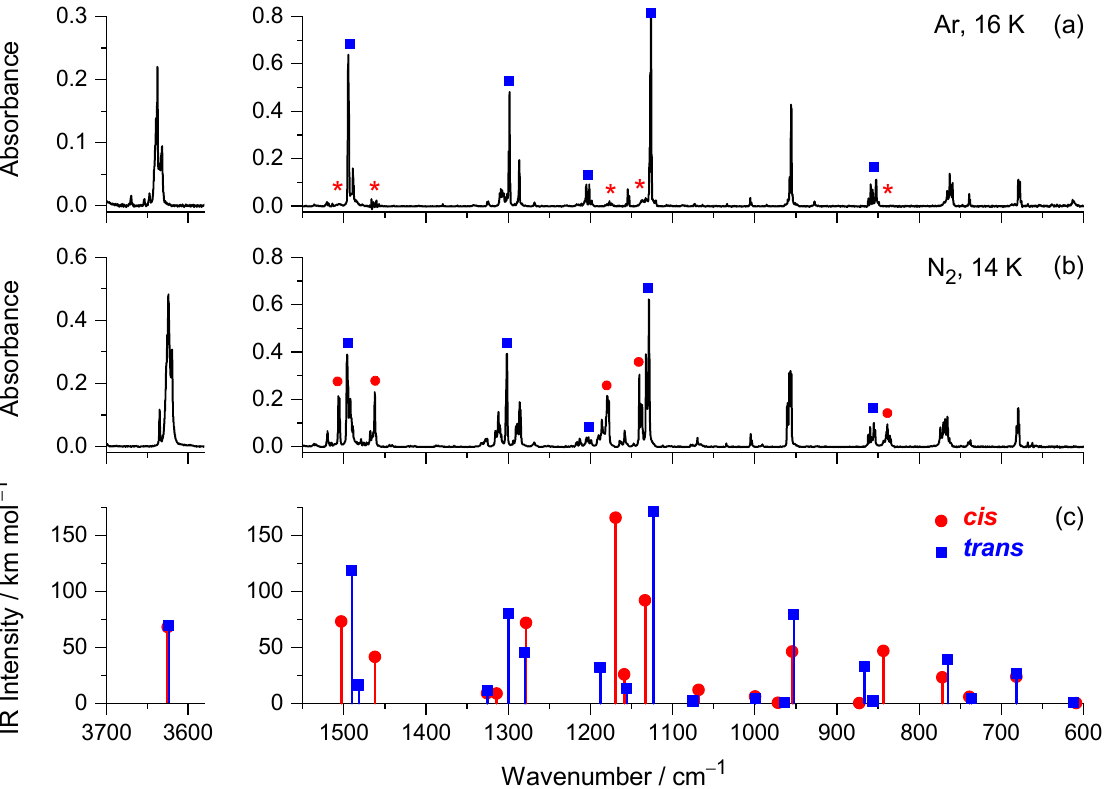
Figure 1. Experimental mid-IR spectra of m FP recorded after isolating monomers of the compound in Ar ( a ) and N 2 ( b ) matrices, compared with the spectra calculated for the cis and trans conformers at the B3LYP/aug-cc-pVTZ level of theory ( c ). Asterisks in frame ( a ) indicate expected spectral positions for the cis conformer (not detected in the Ar matrix).